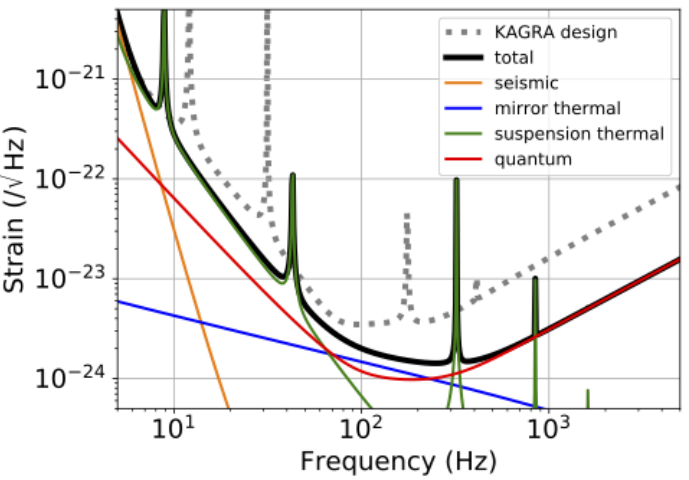
Figure 18. Estimated sensitivity curve after the modifications described in this section. Adapted with permission from Ref. [61], ©2020 American Physical